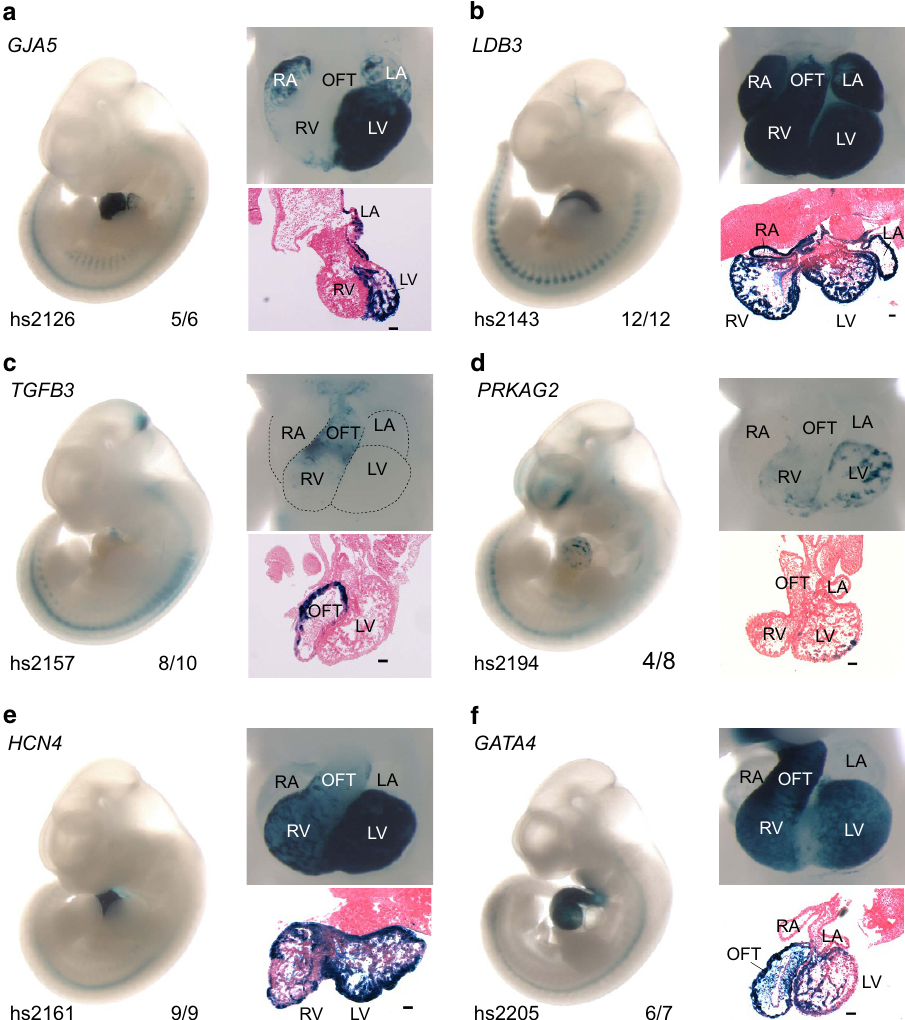
Figure 3 | In vivo activity of human heart enhancers near heart disease genes. ( a – f ) Whole mount (left), heart close up (top right) and histological section (bottom right, scale bar, 100 m m) of E11.5 mouse embryos expressing a reporter LacZ gene (dark blue) under the control of a heart enhancer. VISTA Enhancer Browser identifier (hs number), nearest heart disease-associated gene, and the reproducibility of heart enhancer activity are indicated. LA, left atrium; LV, left ventricle; OFT, outflow tract; RA, right atrium; RV, right